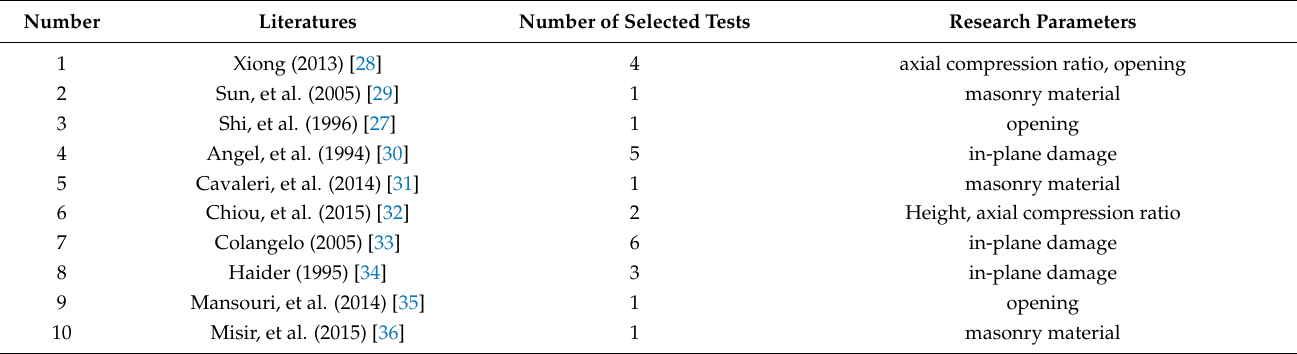
Figure 1. Chronological distribution of the literature. Table 1. The details of the literature.